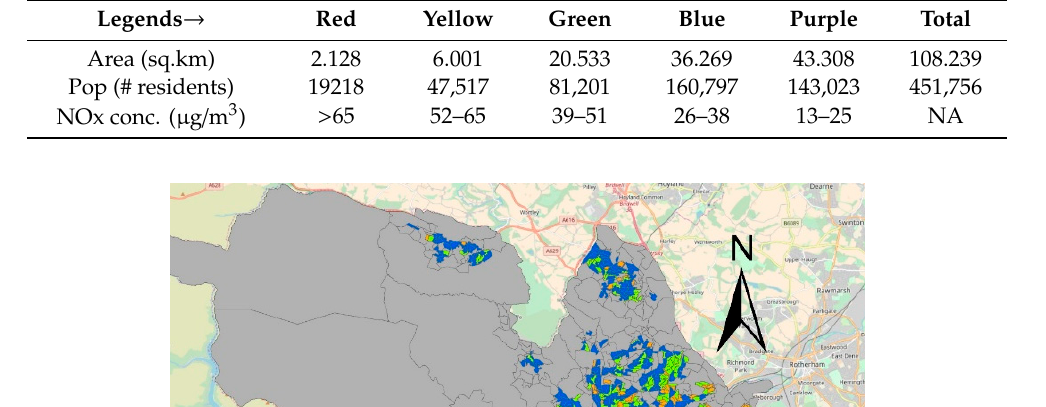
Table 10. Showing area (in km 2 ) and estimated exposed population to air pollution in Sheffield (#: according to Figure 5 (showing NOx concentrations) and Figure 12 (showing population)).